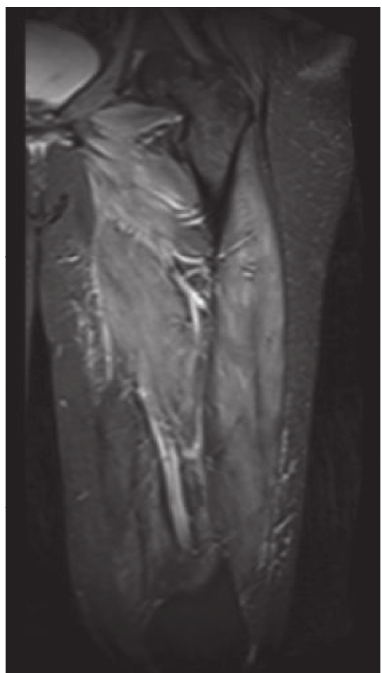
Figure 2: MRI and STIR weighted sequences of the left femur showing extensive intramuscular edema.